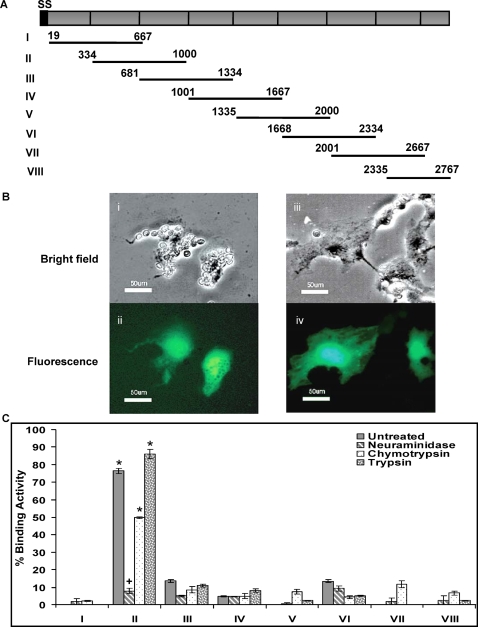
Erythrocyte-binding assay on transfected COS7 cells expressing different regions of PfRH1 before and after enzymatic treatment.(A) Chimeric constructs for the expression of different regions of PfRH1 in 3D7. 3D7 clone RH1 DNA sequence (Genbank accession no: AF533700) with intro spliced out includes signal sequence (SS, black) and Exon2 (grey) encoding a large extracellular domain and excludes transmembrane domain and cytoplastic tail. The extracellular domain was divided into eight regions (From I to VIII). Each region (black line with amino acids no.) is approximately 2 kb with 1 kb overlap between 2 consecutive regions except VIII, which is 1.3 kb. (B) Duffy-positive human erythrocytes bound to the surface of COS7 cells were visualized as rosettes at a magnification of ×200. (i) Two cells formed rosettes with Duffy-positive human erythrocytes on bright field. (ii) Cell-associated fluorescence as GFP (green) was found on the same field as in panel (i). (iii) Negative count of rosette on transfected COS7 cells on bright field. (iv) But two transfected cells (green) were shown on the same field as in panel (iii). Bar, 50um. (C) Comparison of Erythrocyte-binding assay with different regions of PfRH1 after enzymatic treatment. Rosettes were scored in 30 fields at 200× magnification. Data are present as percentage of binding activity (%) after the number of observed rosettes was normalized to 5% transfection efficiency in three independent experiments. The error bar denotes the SE. * p<0.001, indicating that the binding ability of RII is significantly different from those obtained from other regions. + p<0.001, indicating that after neuraminidase-treatment, the binding of RII was significantly decreased compared to untreated erythrocytes.